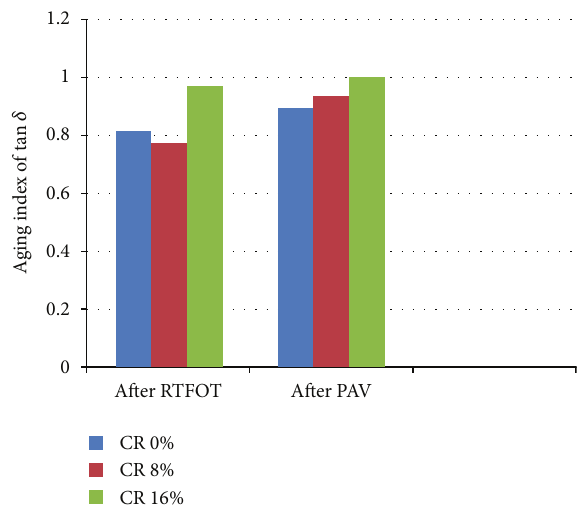
Figure 8: Effect of aging on Tan 𝛿 of bitumen